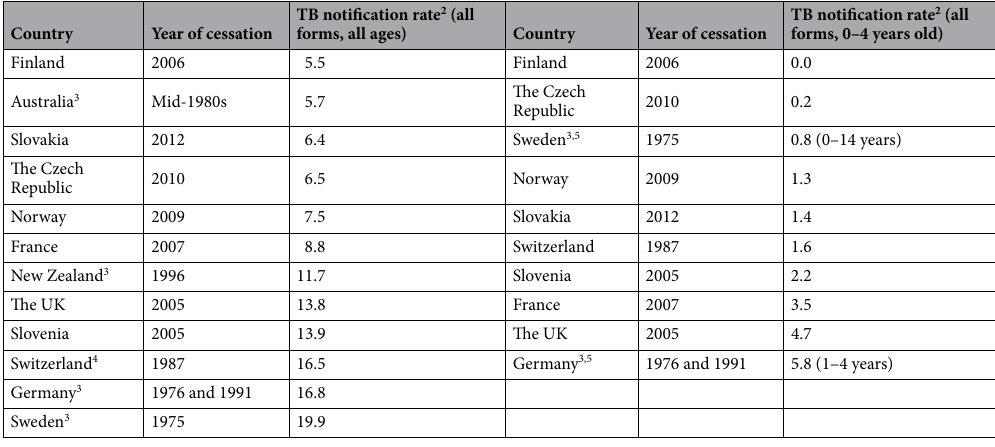
Table 2. TB notification rate (all ages, 0–4 years) at cessation of universal BCG vaccination 1 . 1 Data sources: Institute of Health Information and Statistics of the Czech Republic, the German Federal Health Monitoring System, the Swiss Federal Office of Public Health, European Centre for Disease Prevention and Control. Surveillance Atlas of Infectious Disease, tuberculosis (Finland, France, Norway, Slovakia, Slovenia, the UK) (https:// www. ecdc. europa. eu/ en/ tuber culos is/ surve illan ce/ atlas), the TB annual report (Australia and New Zealand), the published paper: Romanus, V., Svensson, A. & Hallander, H. O. The impact of changing BCG coverage on tuberculosis incidence in Swedish-born children between 1969 and 1989. Tuber. Lung Dis. 73 , 150–161 (1992) (Sweden). 2 Rate per 100,000 population. 3 The available data are not from the exact year of cessation for the following countries: Australia (1986), Germany (1991), New Zealand (1995), and Sweden (1974). 4 The year of data is 1988 (2.1 in 1987, which was the first year of data collection). 5 The data are for patients 1–4 years of age for Germany and 0–14 years of age for Sweden. BCG bacillus Calmette–Guérin, TB tuberculosis, UK United